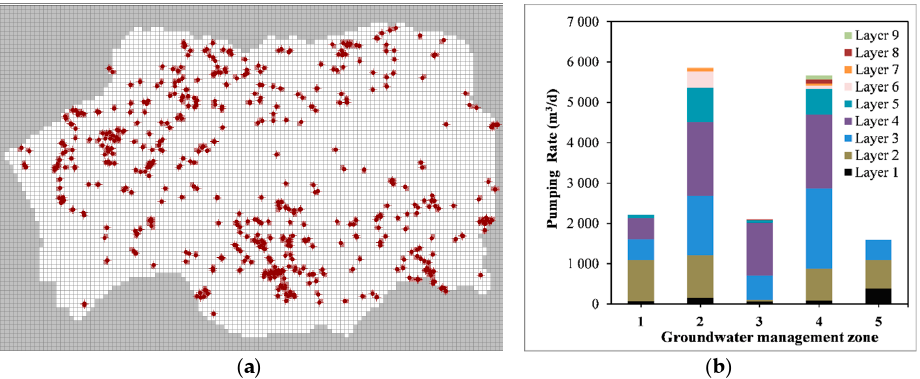
Figure 12. Locations of pumping well ( a ) and pumping rates in groundwater management zones from model layers ( b ).